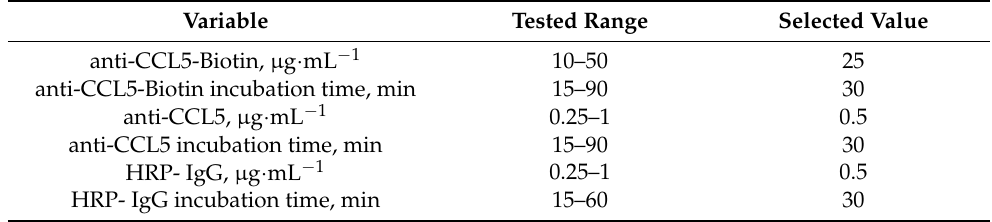
Table 1. Optimization of the experimental variables involved in the preparation of HRP-IgG-anti- CCL5-CCL5-anti-CCL5-Biotin-Neu-MBs bioconjugates used for the amperometric determination of CCL5. Variable Tested Range Selected